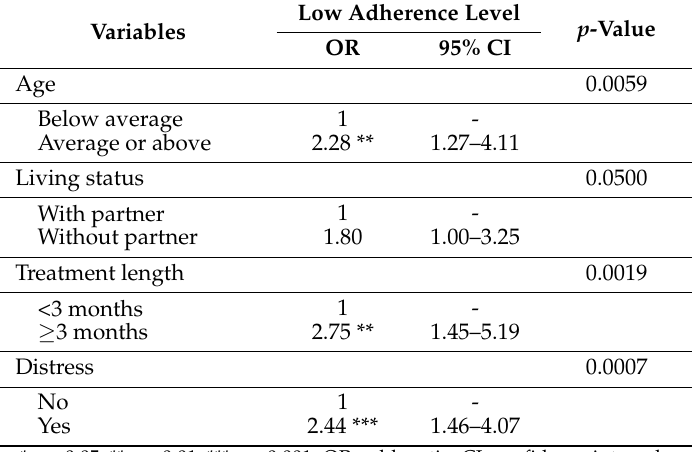
Table 4. Variables related to low medication adherence in multiple logistic regression analysis.